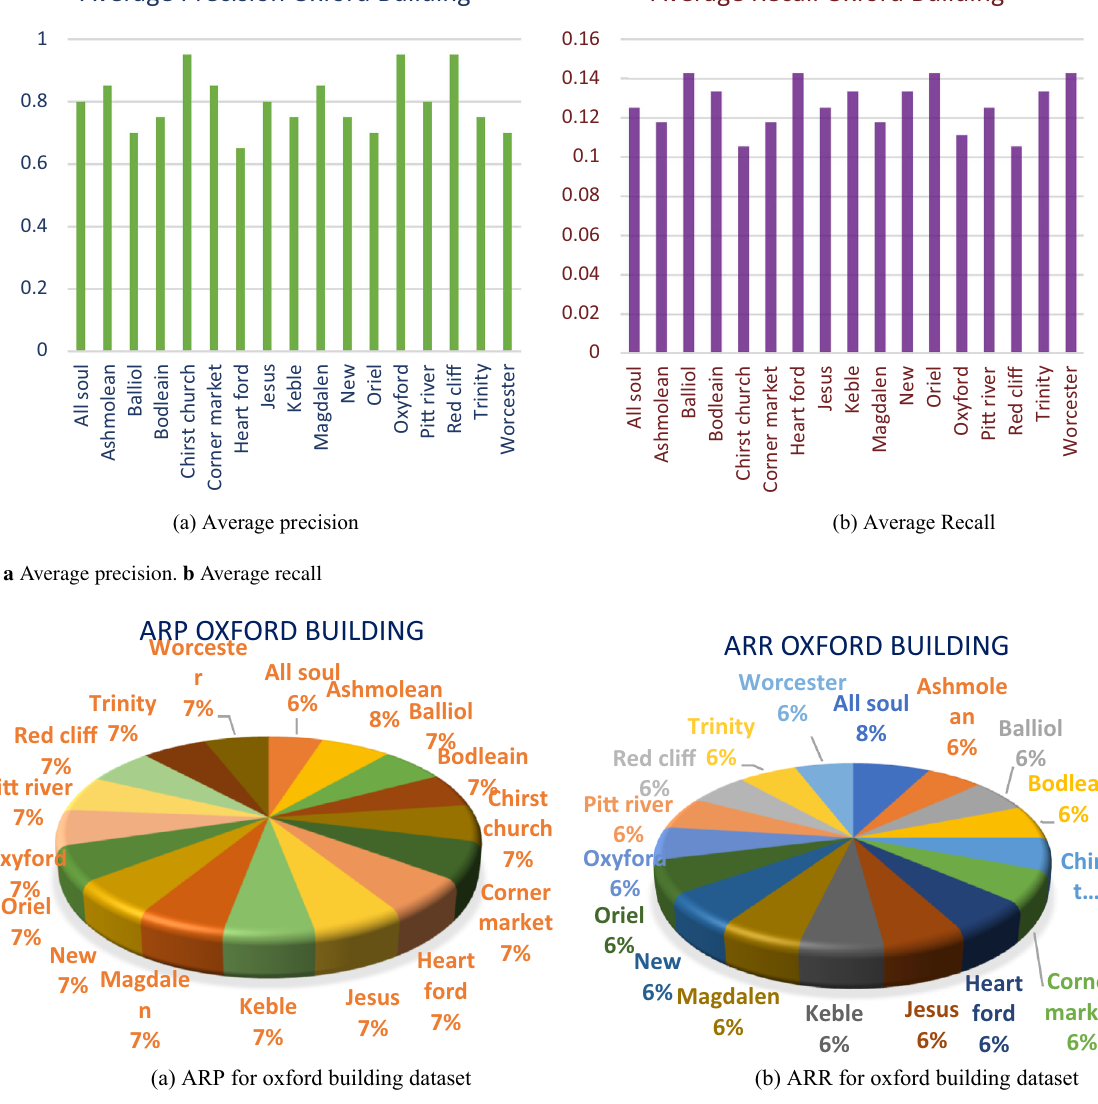
Fig. 16 a ARP for oxford building dataset. b ARR for oxford building dataset